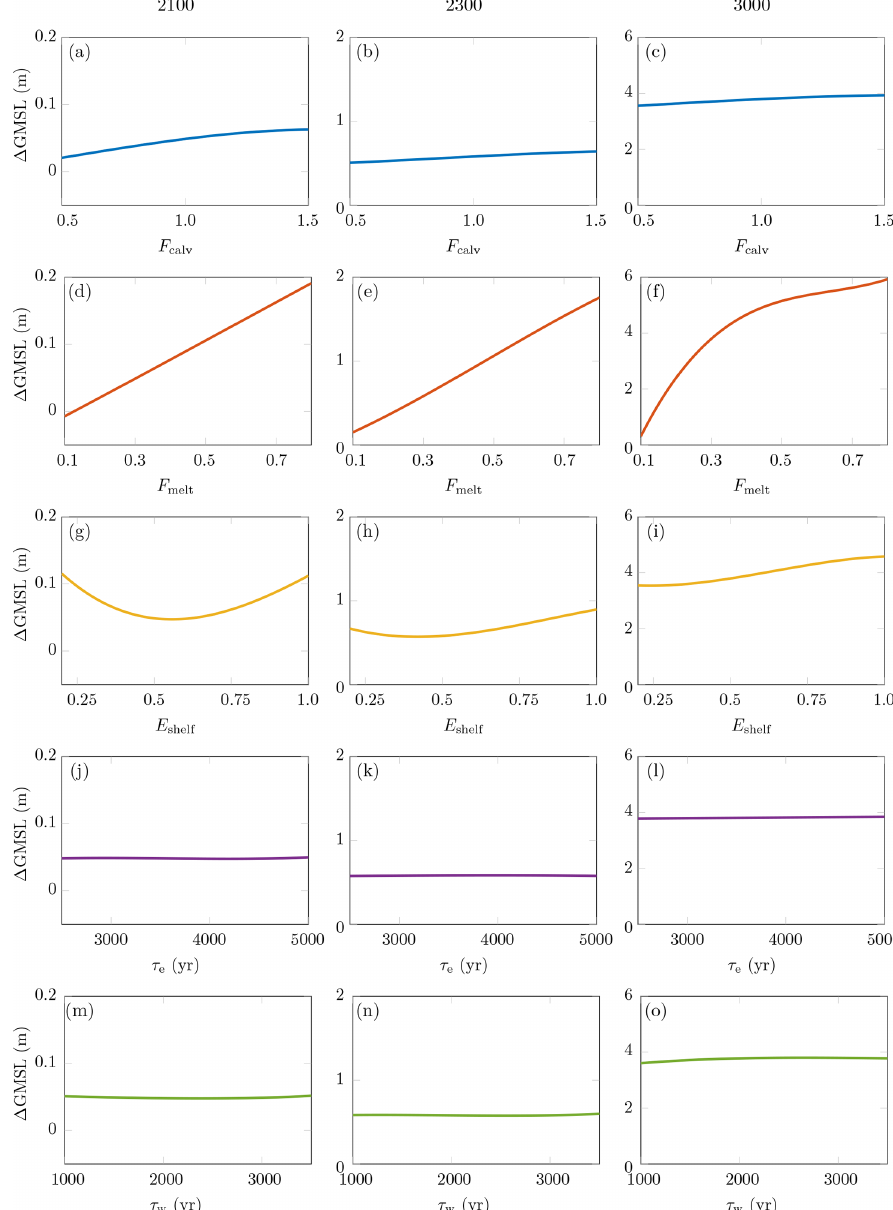
Figure 5. Same as Fig. 4 but in RCP 8.5.